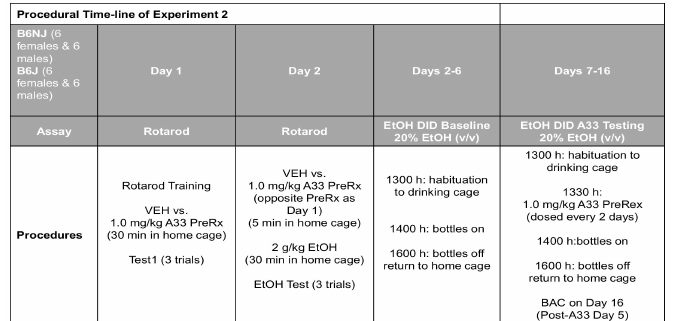
Figure 8. Summary of the procedural timeline for Experiment 2, which first determined the effect of 1.0 mg/kg A33 upon basal and alcohol-induced changes in rotarod performance in experimentally naïve mice, followed by an examination of the effect of repeated pretreatment with 1.0 mg/kg A33 upon alcohol (EtOH) intake under a single-bottle drinking-in-the-dark (DID) procedures.